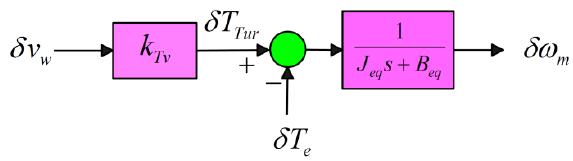
Figure 4. Small-signal block diagram of the mechanical part.